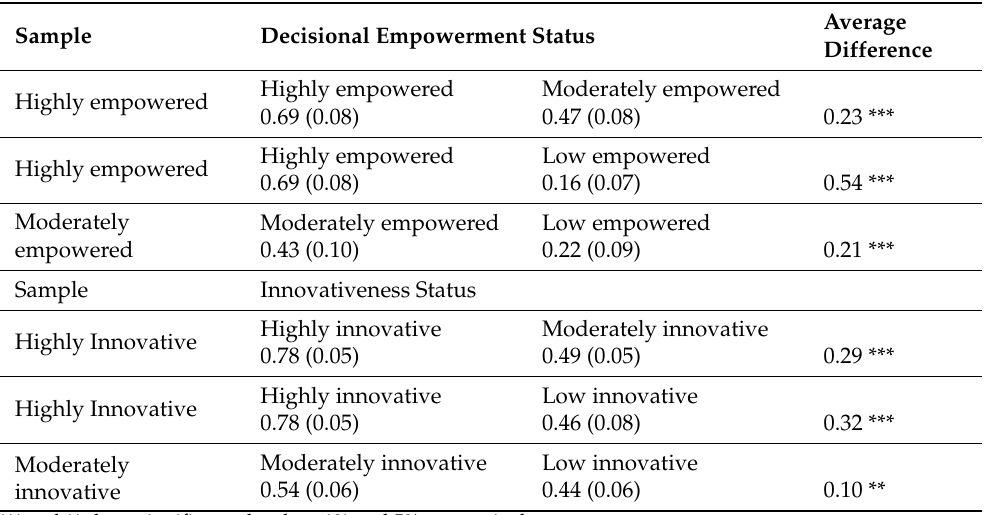
Table 4. Average effect of decisional empowerment and innovativeness on the adoption of CSA practices.